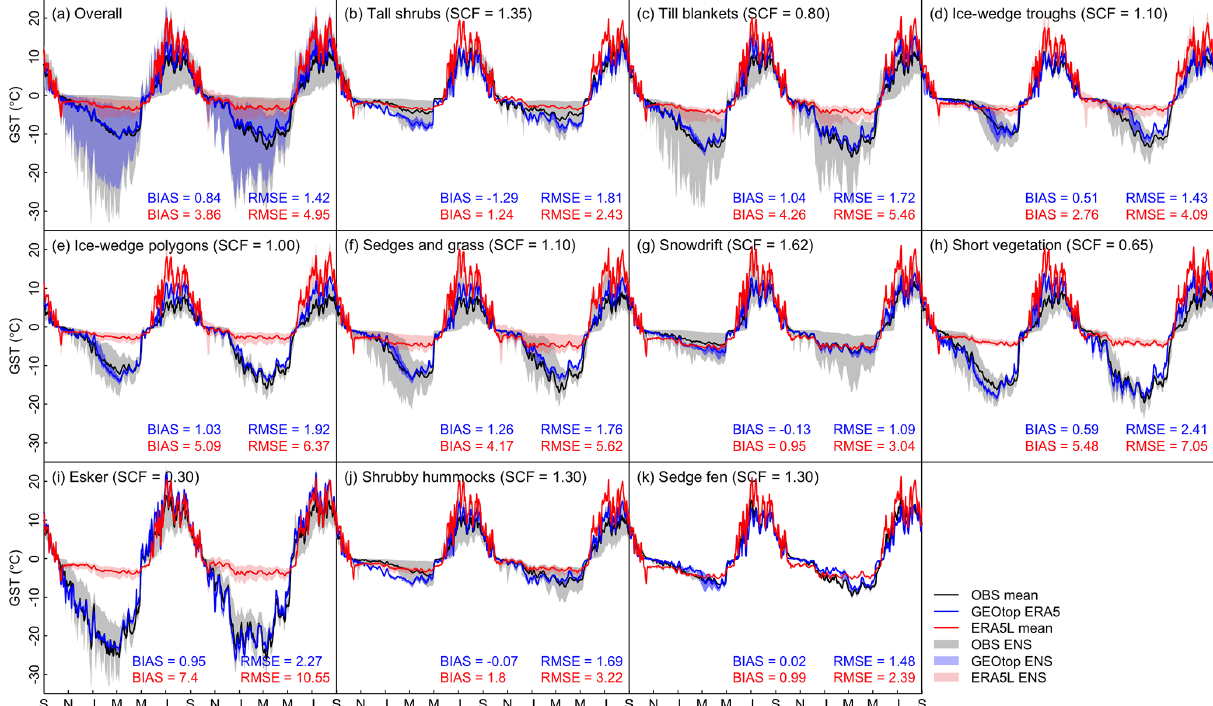
Figure 6. Ground surface temperature (GST) at 0.1m depth for 10 terrain types with different snow accumulation tendencies in LdG, northern Canada. Observations and GEOtop ERA5 are taken from Cao et al. (2019a), and GEOtop ENS is the modeled ensemble range forced by the 10-member ensemble of ERA5. Note that soil temperatures from the first layer of ERA5L are used here. The BIAS and RMSE are simulated at a daily scale for each terrain